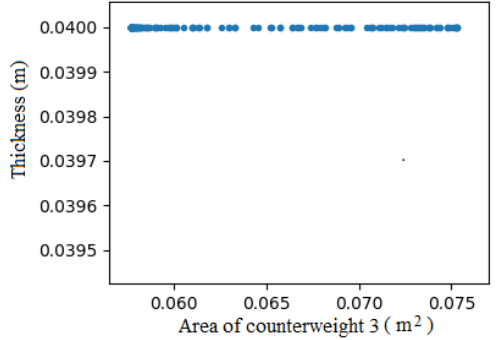
Figure A4. Relation between area and thickness of each cylindrical counterweight when using only